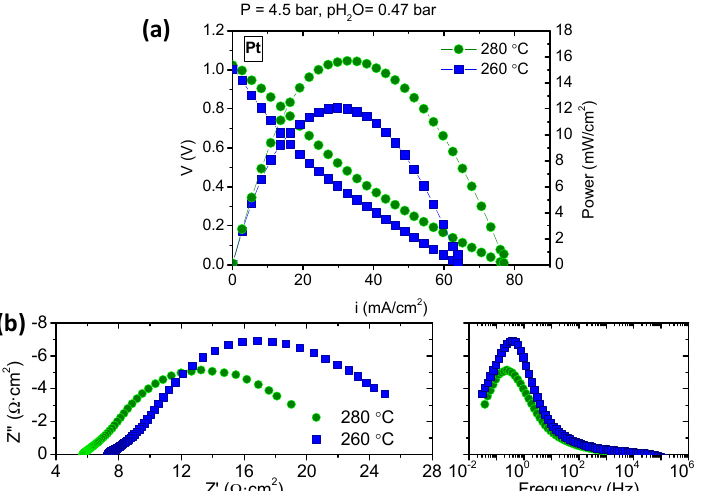
Figure 8. i - V curves ( a ) and Nyquist and Bode plots ( b ) in a fuel cell mode of the Pt on GDL/CsH 2 PO 4 /Pt on GDL at 260 and 280 °C.